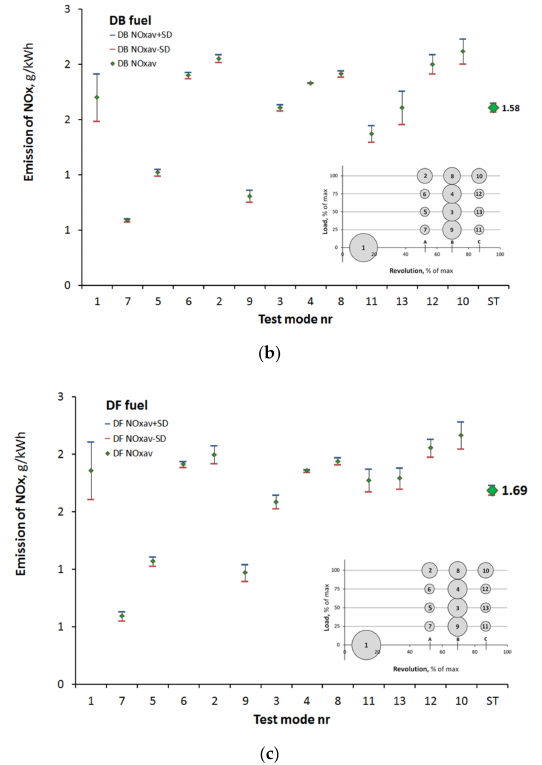
Figure 4. Emissions of NO x of engine in ESC 13 mode test fed with D ( a ), with DB fuel ( b ), and with DF fuel ( c ).